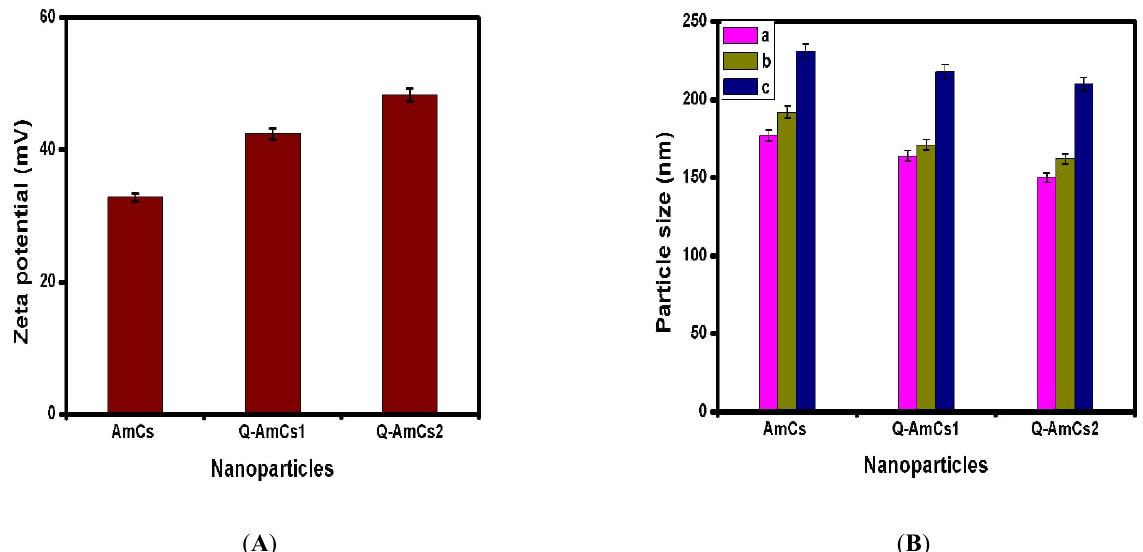
Figure 3. ( A ) Zeta potential and ( B ) particle size values of the formulated nanoparticles at different polymer/TPP ratios of (a) 5:1, (b) 10:1, and (c) 10:1.5. All measurements were performed in triplicates ( n = 3), and values were expressed as mean + standard deviation (±SD).